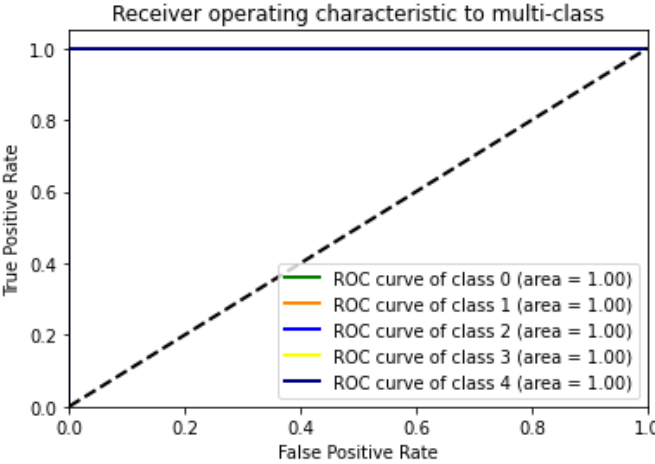
Figure 9. Receiver operating characteristics curve for 500 epochs.